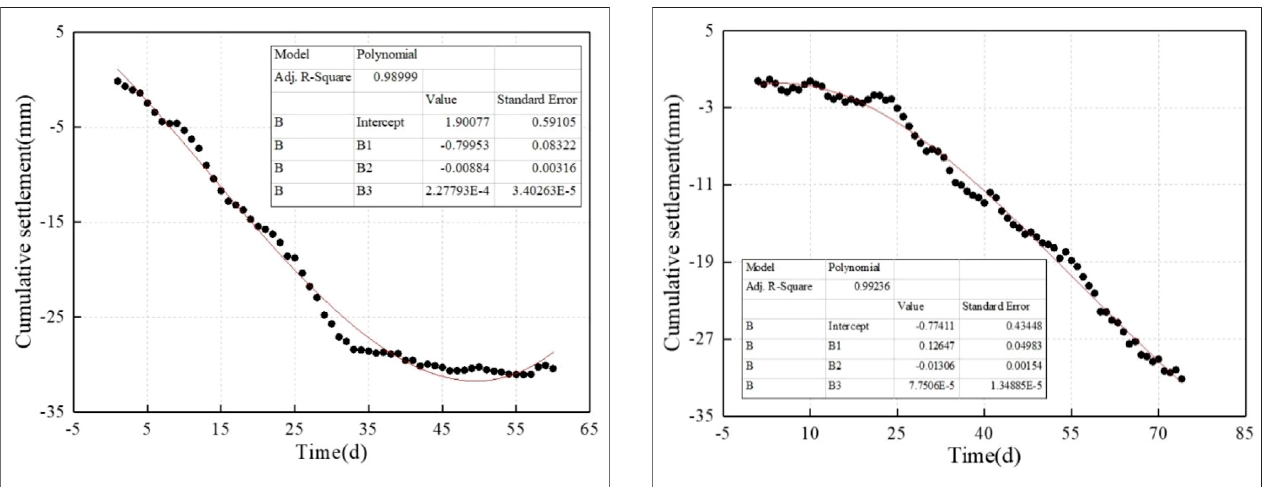
FIGURE 11 | Data change curve fi tting diagram. FIGURE 9 | Data change curve fi tting diagram of the fi rst